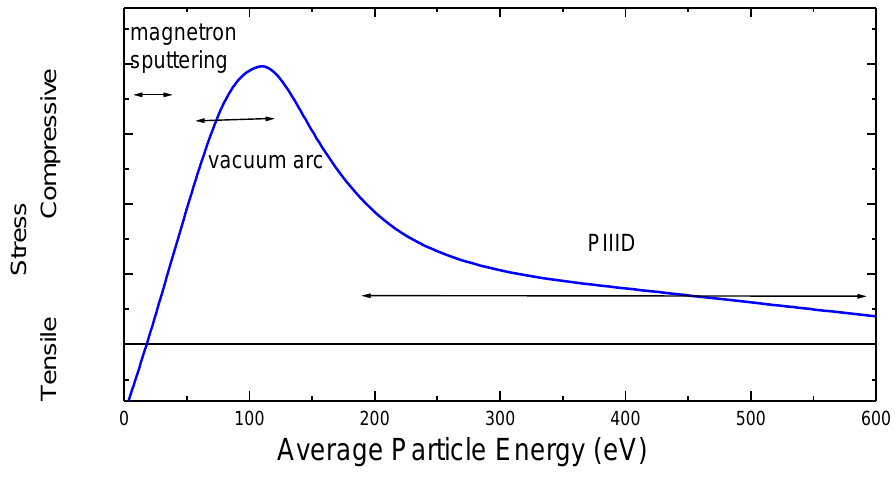
Figure 13 . Evolution of intrinsic stress as a function of deposited energy. Typical energy regions for different processes are